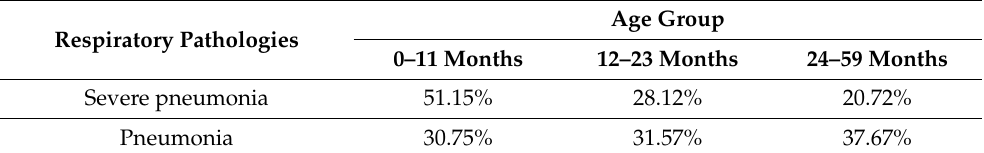
Table 5. Distribution of respiratory diseases in children under five by age.